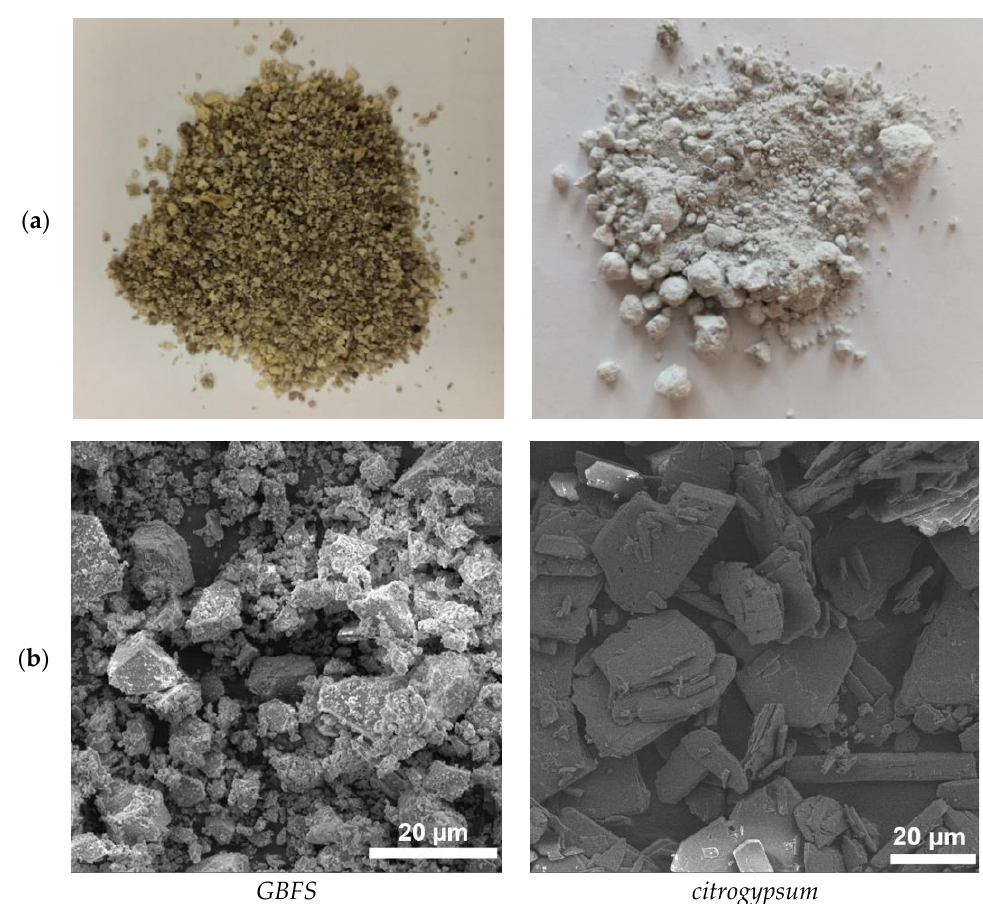
Figure 4. Natural appearance ( a ) and SEM-images ( b ) of GBFS and citrogypsum.